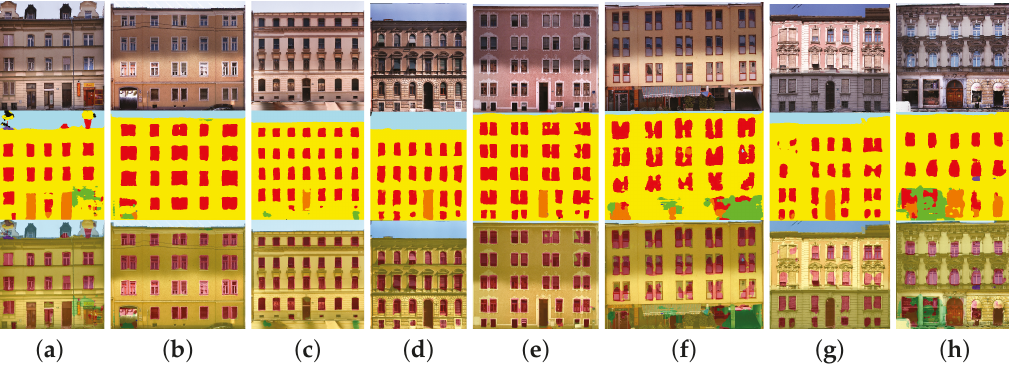
Figure 10. Results over the Graz dataset. ( a – h ) Example of Graz images, segmented by the neural model presented in Section 4.1.2. The three different rows correspond to the same description as in Figure 5.